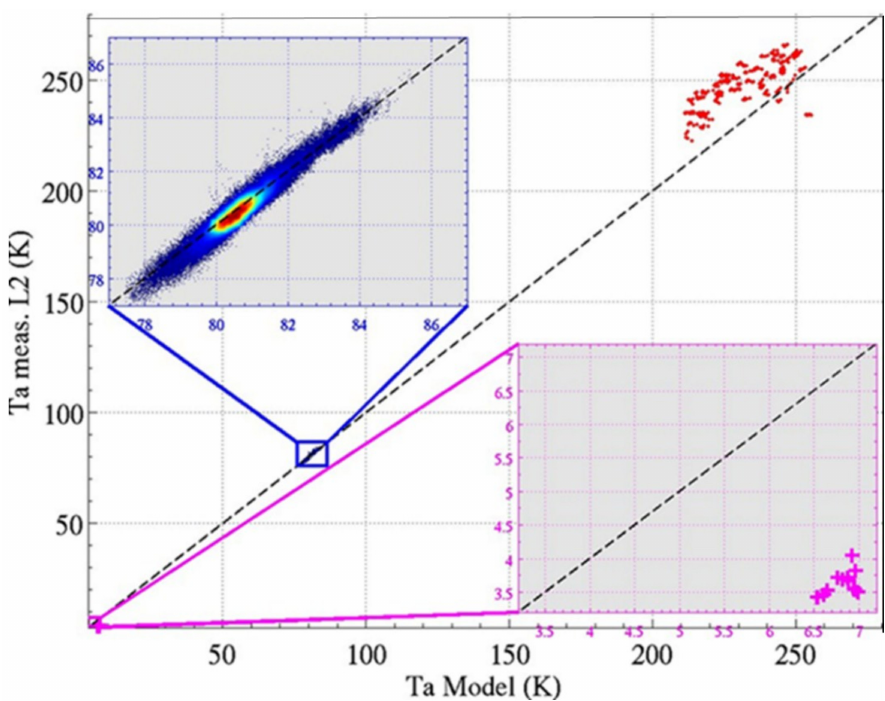
Figure 10. Aquarius measured antenna temperature, Ta_measured, plotted against the antenna temperature predicted with the forward model, Ta_model, for three regimes: cold sky (magenta insert), ocean (blue insert), and land (Little River watershed, red dots). The data is for horizontal polarization, and the middle beam and the measurements are from V2.0 of the algorithm. (Author’s figure from Le Vine et al.